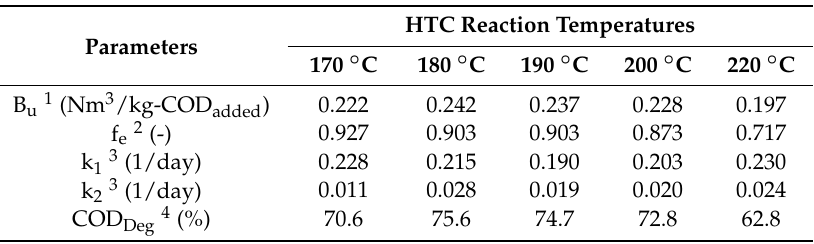
Table 5. Ultimate methane potential and model parameters based on the parallel first-order kinetics